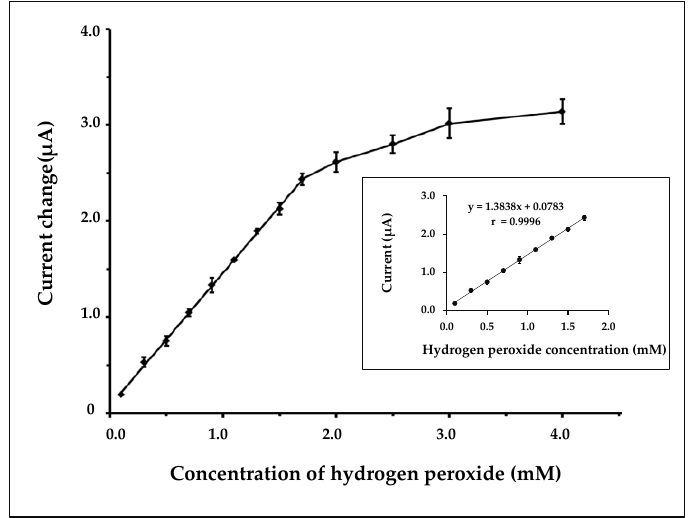
Figure 5. Calibration curve at different concentrations of hydrogen peroxide. The error bars show standard deviations for n = 3. Inset: the linear part of the calibration curve.